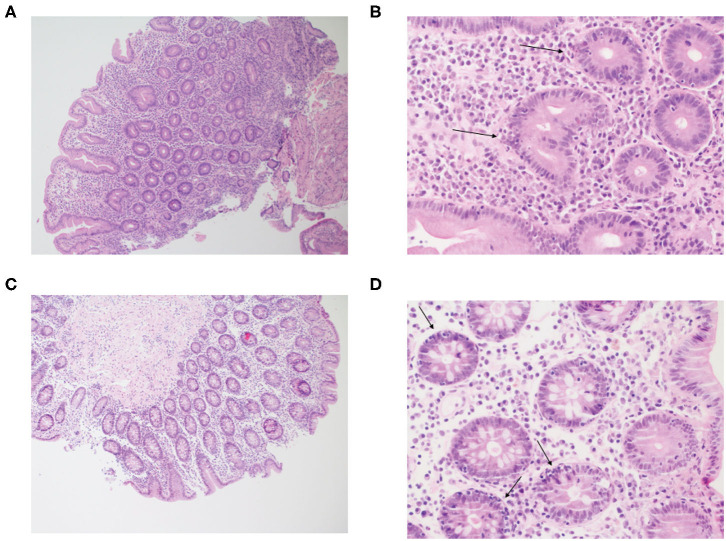
Inflammatory cell infiltration of the small and large intestine in the patient with LRBA deficiency. Figure displays hematoxylin and eosin (H&E) stain at (A) ×100 and (B) ×400 of duodenal biopsies. The mucosa shows flattened villi and hyperplastic crypts, with an increase in plasma cells in the lamina propria. Crypt epithelium shows increased intraepithelial lymphocytes (arrows). Next, an H&E stain of the transverse colon is presented at (C) ×100 and (D) ×400. The structure of the colonic mucosa is preserved. The stroma is infiltrated by mononuclear inflammatory cells and the crypt epithelium shows increased intraepithelial lymphocytes (arrows), similar to the duodenal biopsy. The lamina propria shows increase in plasma cells.